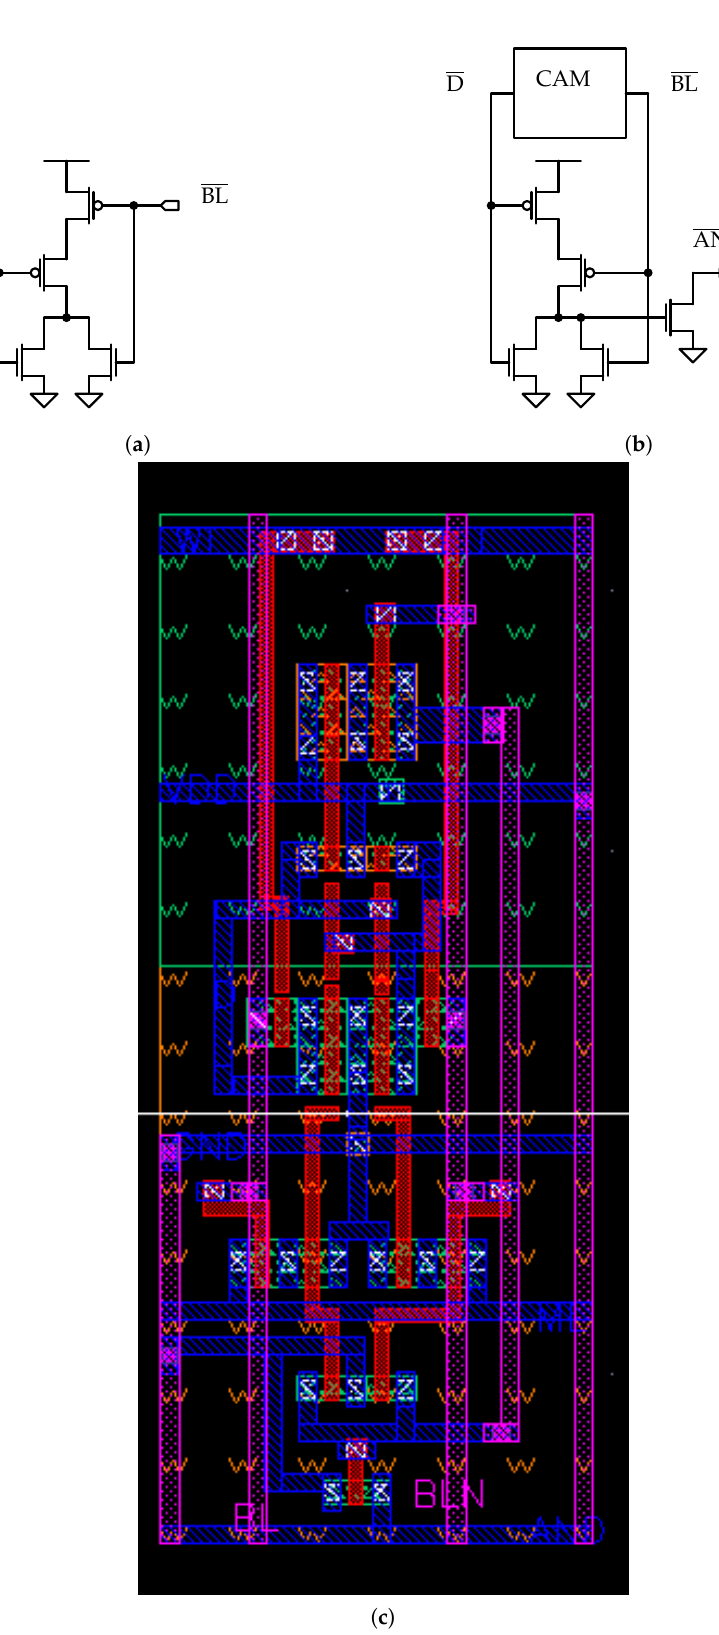
Figure 10. The static AND gate and memory cell. ( a ) The static CMOS AND gate. ( b ) The memory cell that embeds the static AND gate. ( c ) The cell